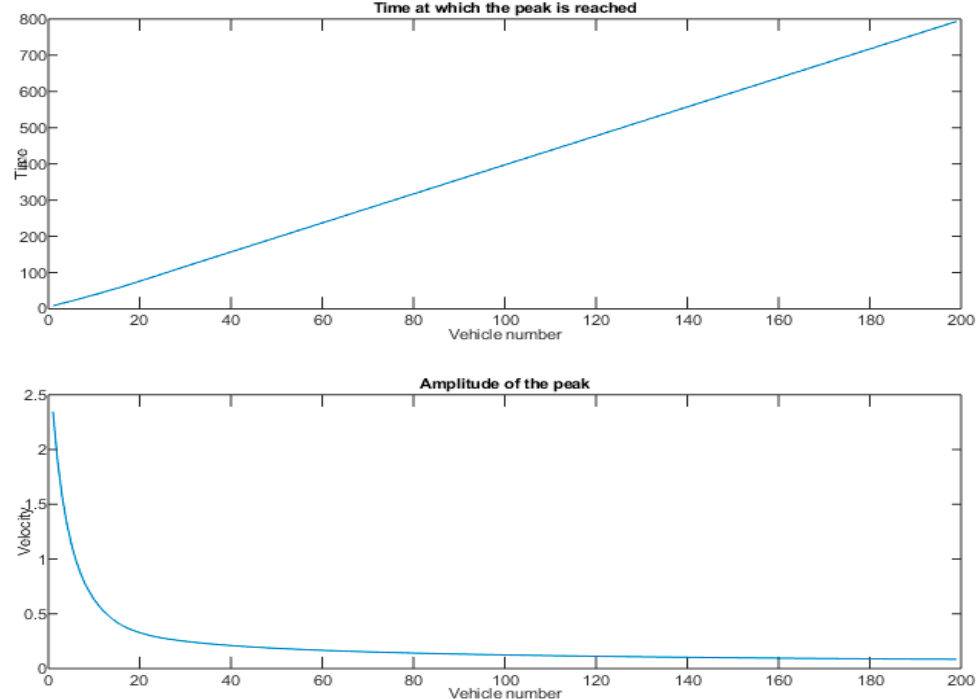
Figure 8. Time at which the harmonic disturbance imparted to the leader reaches each vehicle, on ( top ), and peak velocity, on the ( bottom ), versus the vehicle number.